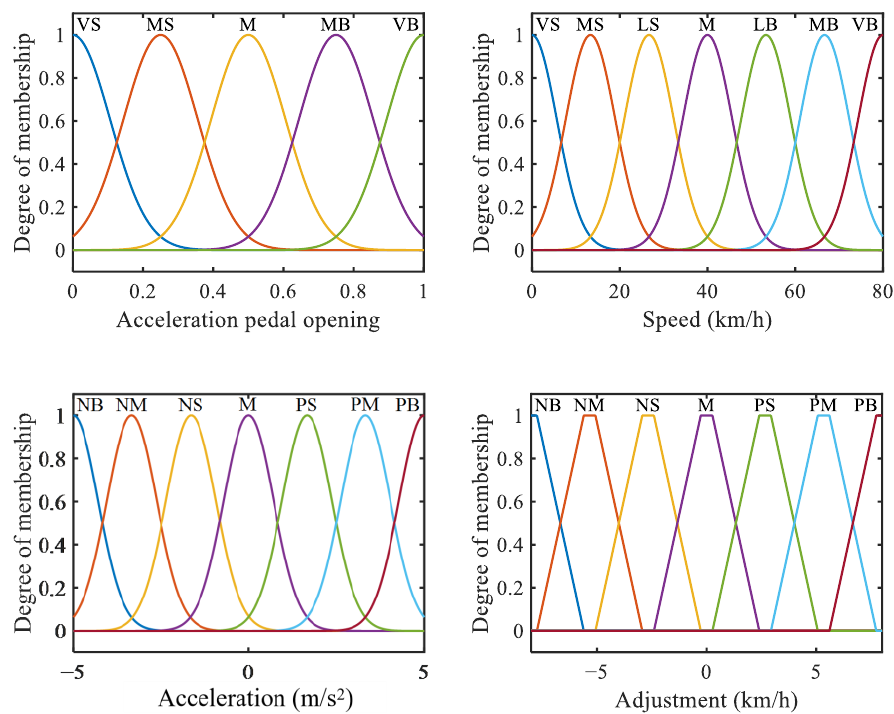
Figure 8. Membership functions of the input and output variables in fuzzy rules of economic shifting strategy.